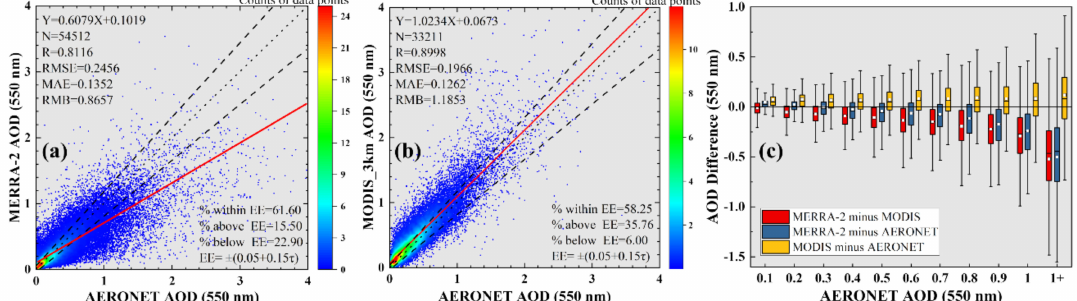
Figure 3. Density scatterplots of ( a ) MERRA-2 and ( b ) MODIS AOD against the AERONET AOD. Solid red lines are regression lines. Dotted lines represent the 1:1 line. Dashed lines constrain the expected error (EE) envelopes. Box plots of AOD difference for MERRA-2, MODIS, and AERONET against AERONET AOD ( c ). Red, blue, and yellow represent difference in MERRA-2 minus MODIS AOD, difference in MERRA-2 minus AERONET AOD, and MODIS minus AERONET AOD versus AERONET AOD, respectively. The black horizontal solid line denotes the zero AOD difference. In each box, the upper, middle, and lower horizontal lines denote 75th, median, and 25th percentiles, respectively.